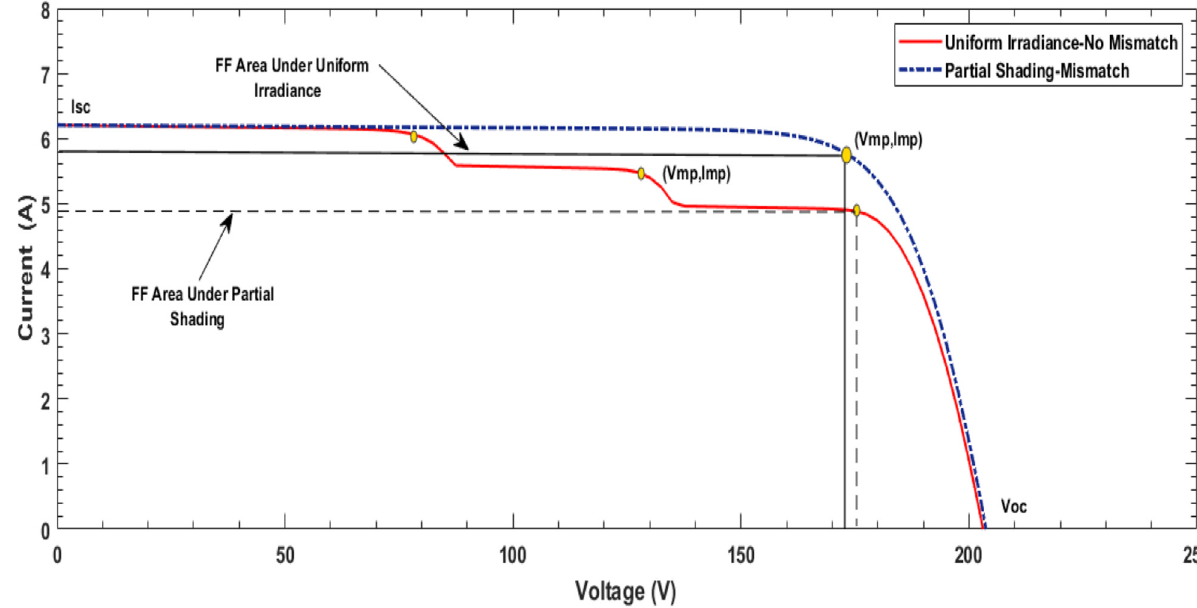
Fig. 2. Output current – voltage ( P – V ) characteristics of photovoltaic modules under STC and partial shading